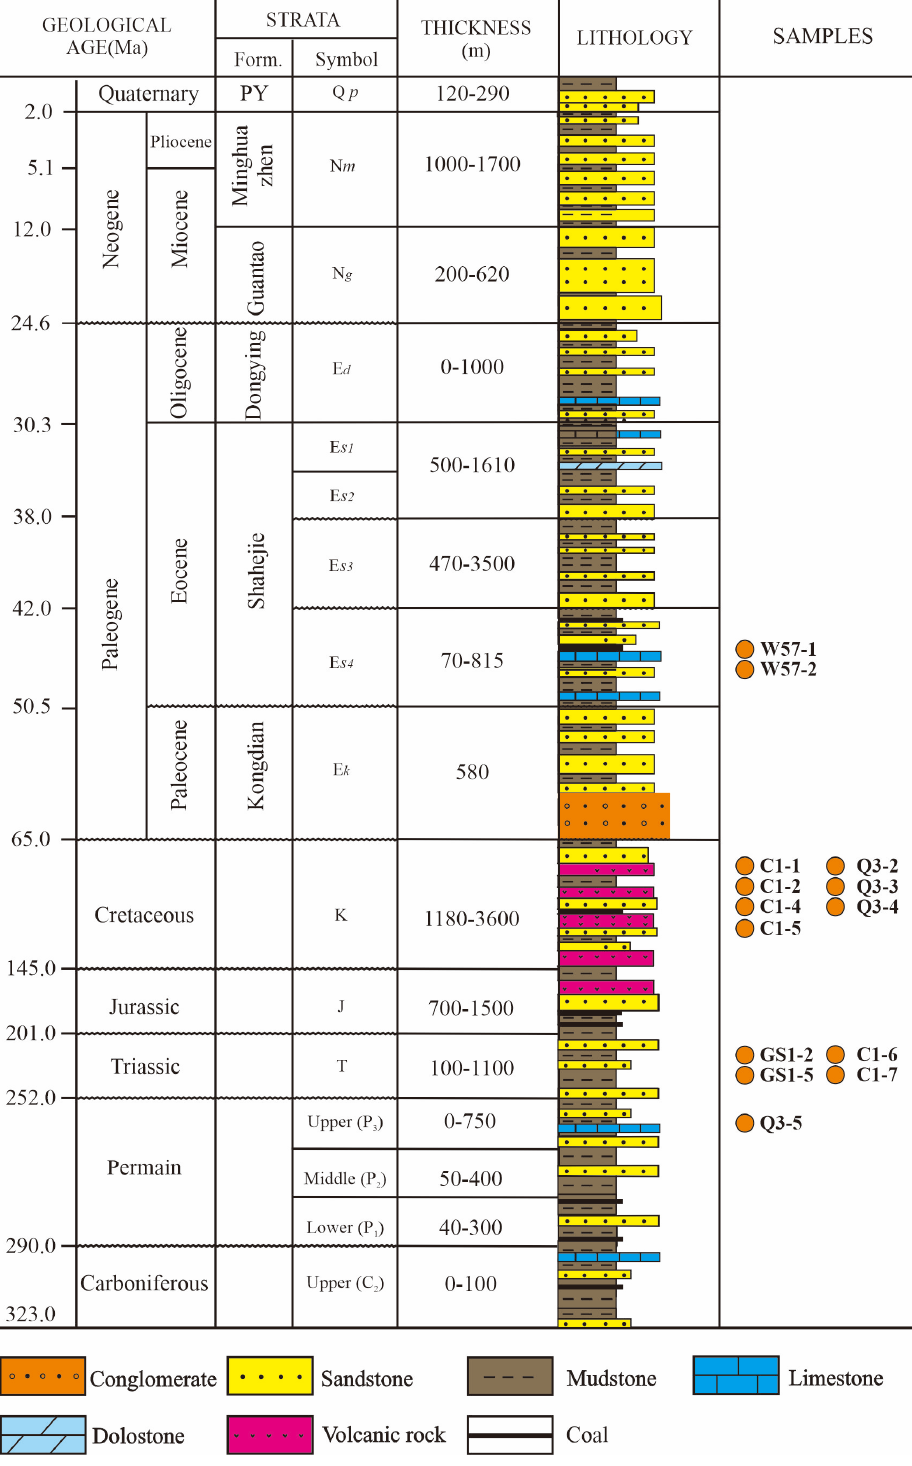
Figure 2. Generalized stratigraphic column of the Linqing Sub-basin (modified from Xu et al., 2020 [20]).